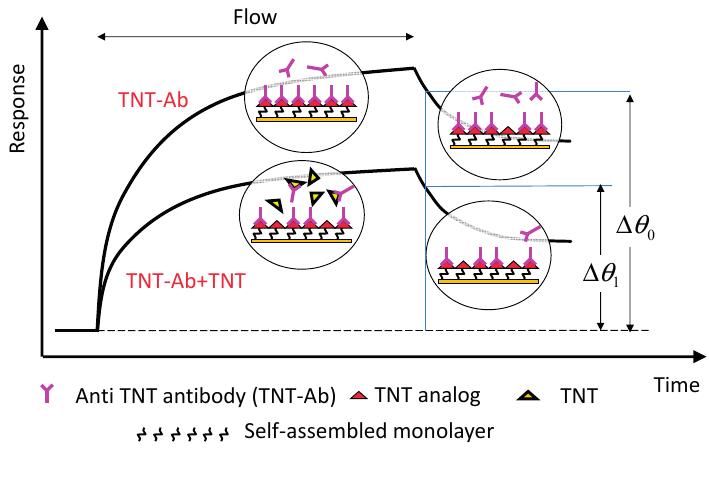
Figure 2. Principle of indirect competitive